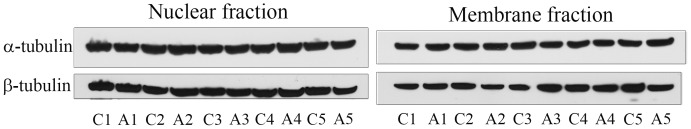
Western blot of α- and β-tubulins in nuclear and membrane fractions from the prefrontal cortex of control and alcoholic subjects.Control (C) or alcoholic (A) prefrontal cortex nuclear and membrane fractions were resolved by 1D PAGE and proteins Western blotted for α- and β-tubulins.